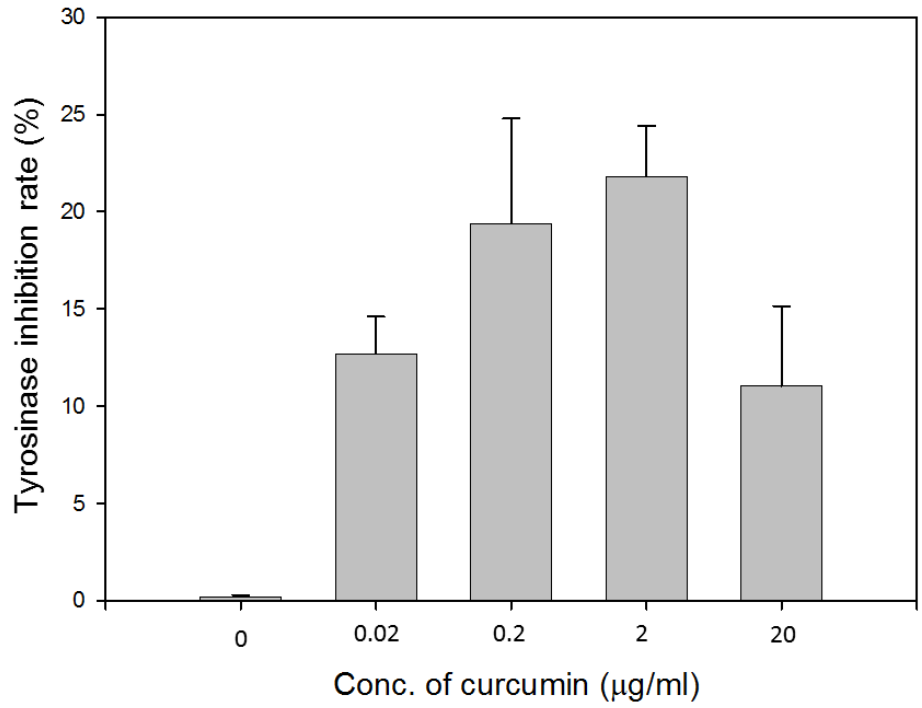
Figure 3. Inhibitory effects of various concentrations of curcumin against tyrosinase